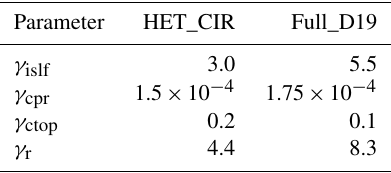
Table 2. Model configuration comparison between the “HET_CIR” simulation by Dietlicher et al. (2019) and our “Full_D19” reference simulation presented in this study. The tuning parameters include ice self-collection ( γ slf ), the autoconversion rate from cloud liquid water to rain within convective cores ( γ cpr ), the convective cloud mass flux above the level on non-buoyancy ( γ ctop ), and the auto- conversion rate within stratiform liquid clouds ( γ r